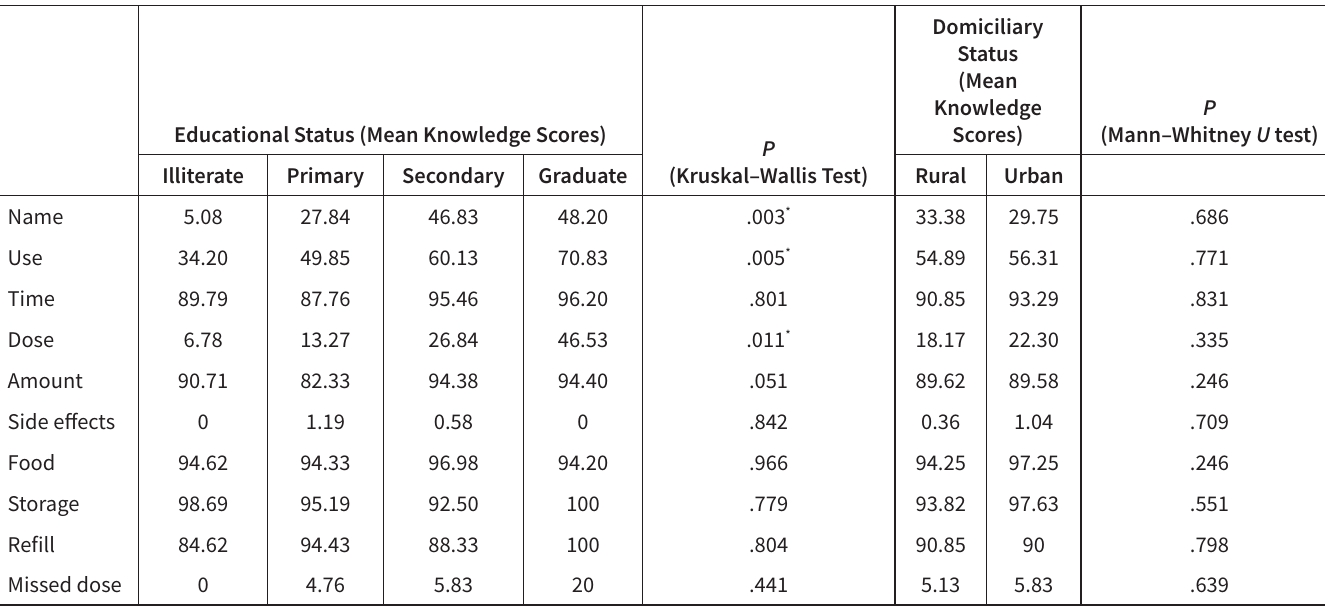
Table 5. Comparison of Medication Knowledge Scores Between Patient’s Educational Status and Domiciliary Status